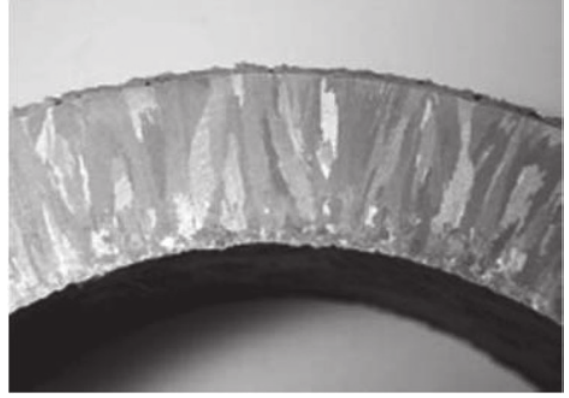
Fig. 7: Macrograph of centrifugally cast structure of a column with yttrium addition, showing the duplex structure [11].